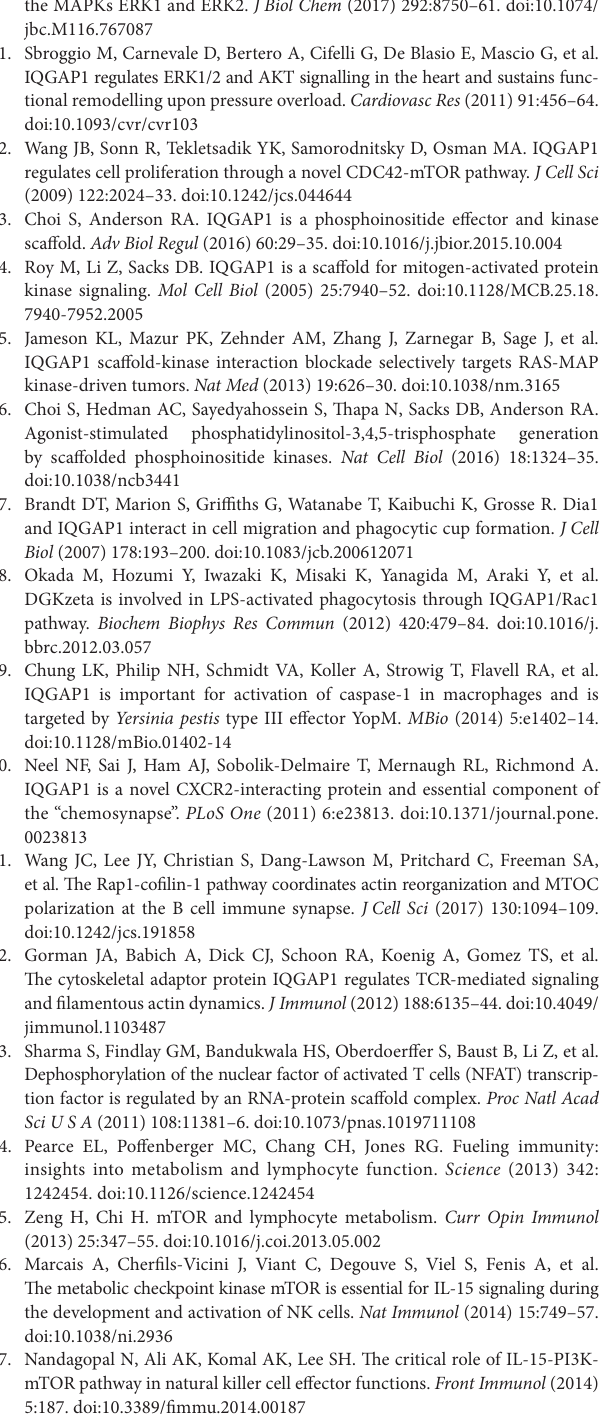
FigUre s2 | Metabolic characterization of Iqgap1 − / − natural killer (NK) cells. Seahorse assay was used to measure ECAR and OCR rates in IL-2 cultured wild-type and Iqgap1 − / − NK cells. (a,B) A glycolytic stress test was used to evaluate glycolytic parameters following the addition of glucose, oligomycin, and 2-DG. (c,D) A mitochondrial stress test was used to evaluate oxidative phosphorylation following the addition of oligomycin, FCCP, and antimycin A. Error bars represent SD using three mice from two independent